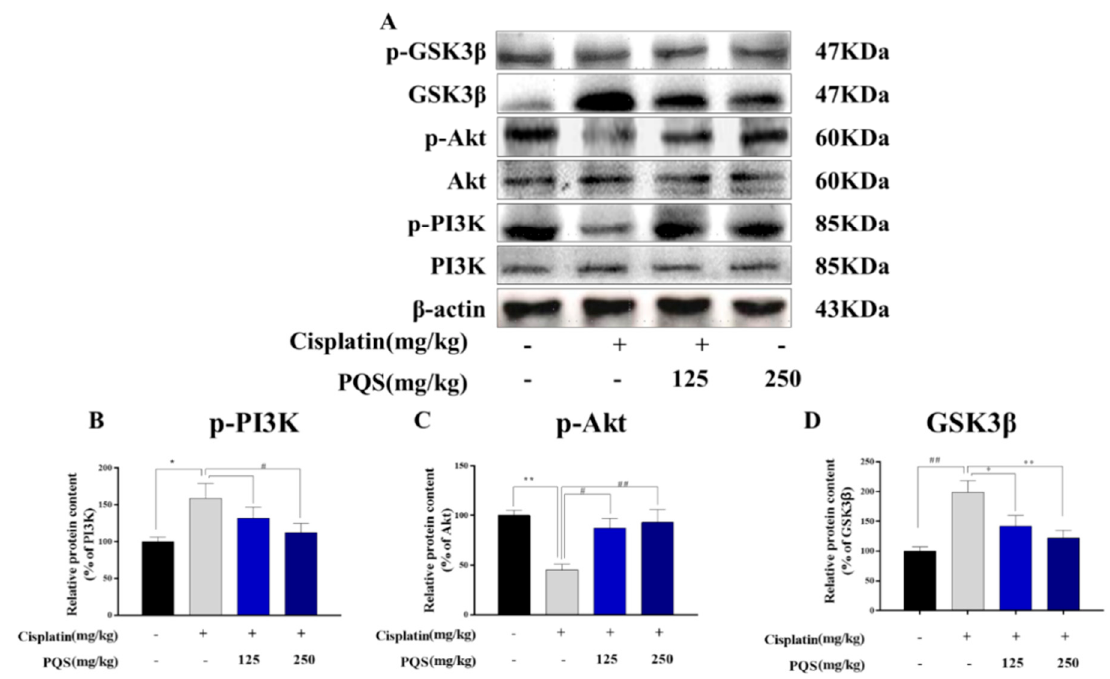
Figure 7. ( A ) The blots of Bax, Bcl-2, Bad, caspase 3, cleaved caspase 3, caspase 8, cleaved caspase 8 and caspase 9, cleaved caspase 9 were standardized to that of β -actin; Quantitative analysis of scanning densitometry for Bax ( B ), Bcl-2 ( C ), Caspase-3 ( D ), Caspase-8 ( E ), Caspase-9 ( F ). ( G ) Representative photomicrographs of cardiac immunohistochemically staining for Hoechst 33258, ( H ) Bax staining area. The percentage of apoptosis ( I ) and Bcl-2 staining area in indicated groups. Scale bars data were expressed as mean ± S.D. * p < 0.05 or ** p < 0.01 comparing with normal group. # p < 0.05 or ## p < 0.01 comparing with cisplatin group.